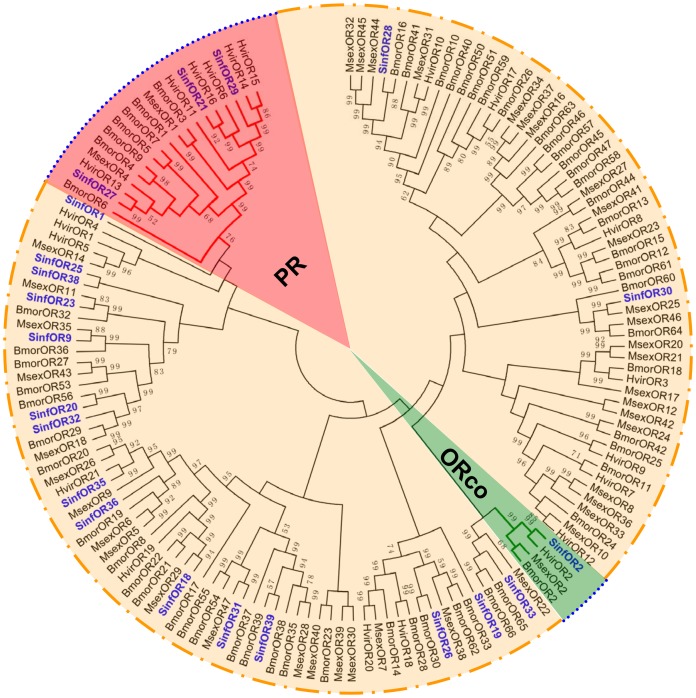
Phylogenetic tree of putative ORs from S. inferens, M. sexta, H. virescens and B. mori.PR clade is marked in red and ORco in green. The S. inferens translated unigenes are shown in blue. Accession numbers are given in Table S3. The tree was constructed with MEGA5.0, using the neighbour-joining method. Values indicated at the nodes are bootstrap values based on 1000 replicates, and the bootstrap values <50% are not shown. Sinf, Sesamia inferens; Msex, Manduca sexta; Hvir, Heliothis virescenss; Bmor, Bombyx mori.